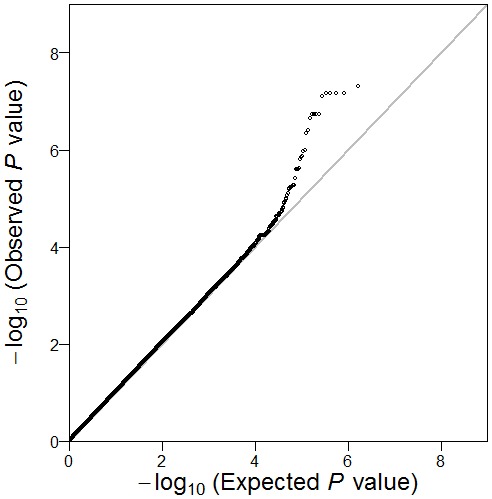
Quantile-Quantile plot of genome-wide quantitative trait loci mapping for log-transformed serum ferritin concentrations.